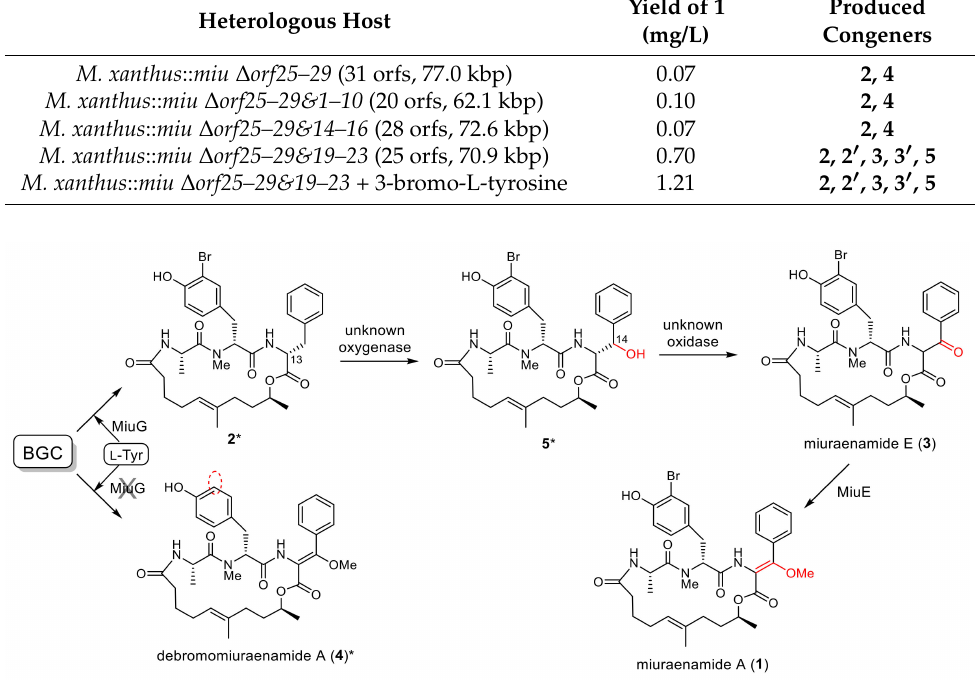
Figure 7. Plausible biosynthetic route for miuraenamide A ( 1 ) and related congeners. The compounds with an asterisk were estimated by the molecular formulae obtained using high-resolution